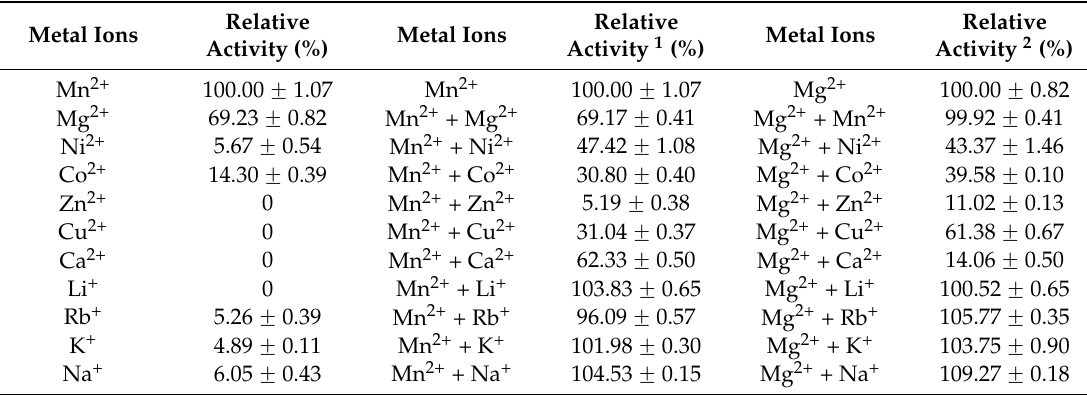
Table 1. Effects of metal ions on the activity of recombinant Bl